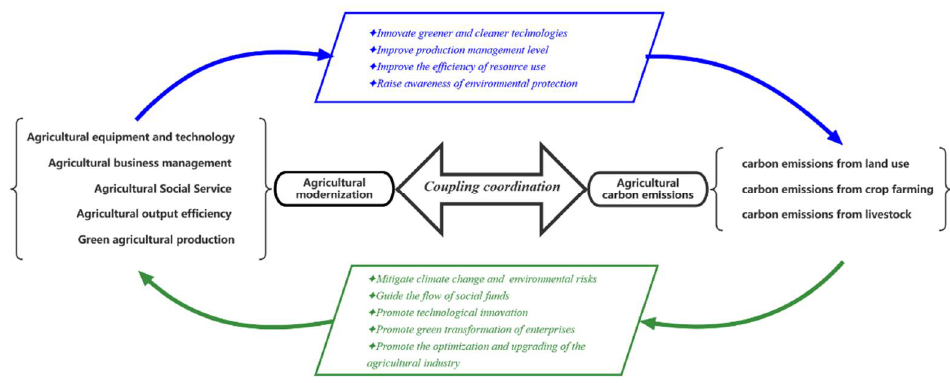
Figure 1. Coupling framework of agricultural carbon emissions and agricultural modernization.